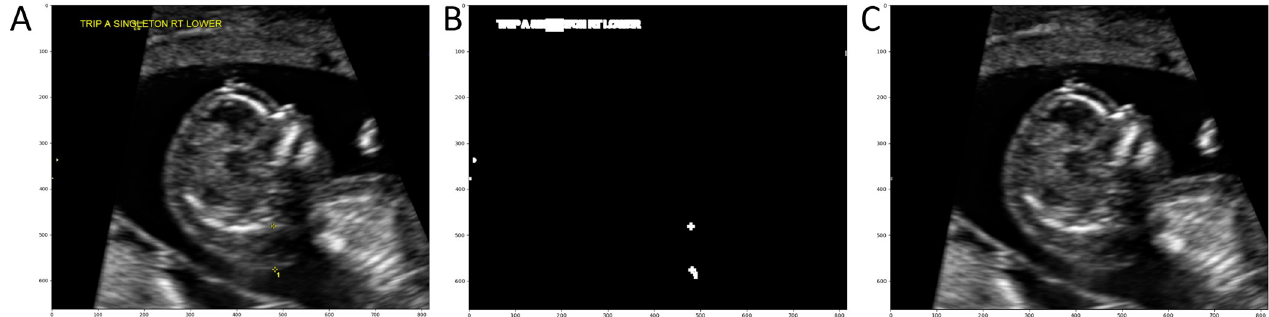
Fig 3. Removal of image annotations on a scan with cystic hygroma diagnosis. (A) Ultrasound image before annotations were removed. Yellow calipers (bottom middle) are visible, along with text annotations (top left). (B) The binary mask of the image which was generated to define the region of the image that need to be infilled (white pixels). (C) Result of the Navier-Stokes image infill method; all image annotations have been removed.